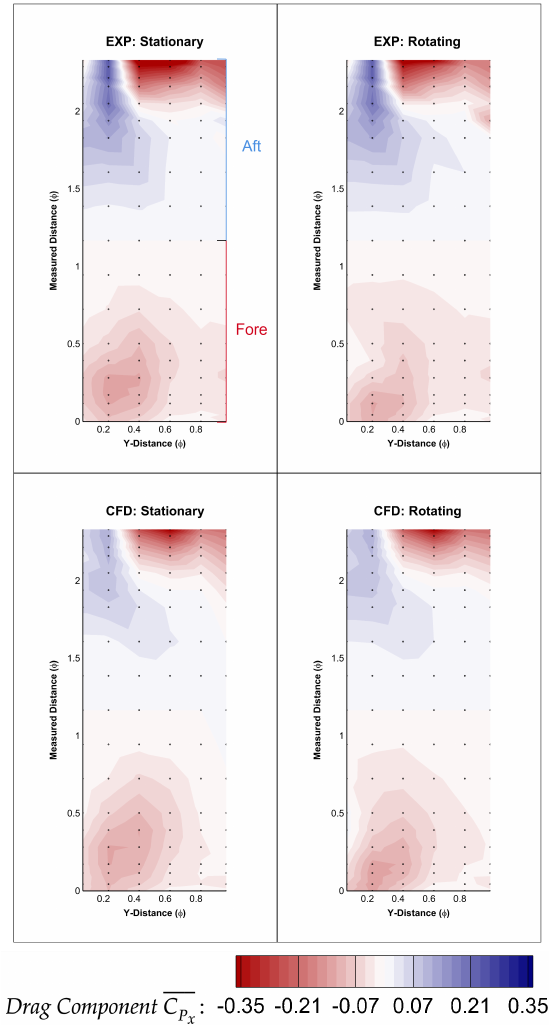
Figure 22. Wheel arch pressures: experimental and computational, drag component.